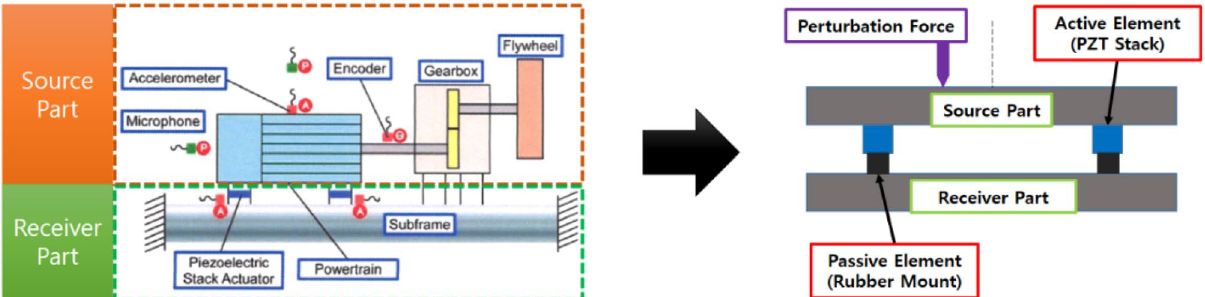
Figure 2. Active element integration for mitigating source movement from perturbation force.